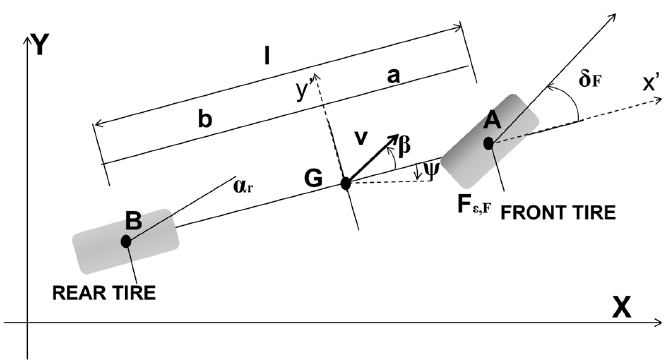
Figure 8. Kinematic bicycle model representation.